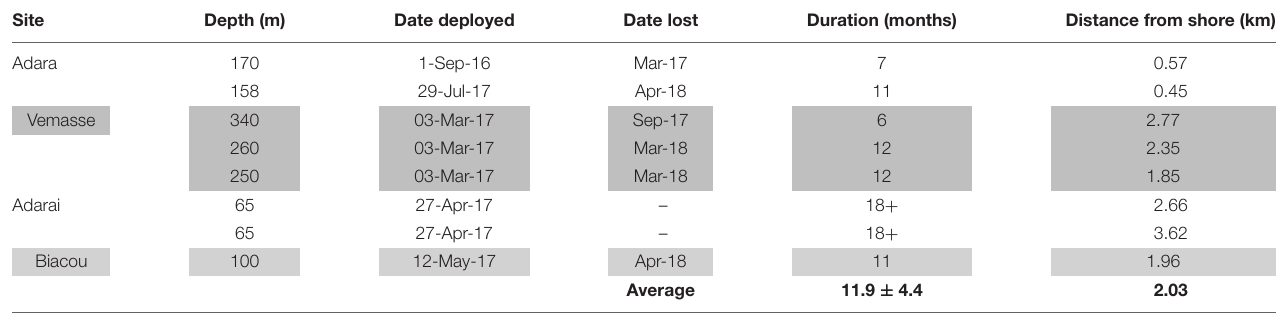
TABLE 1 | Deployment depth and longevity of artisanal nearshore fish aggregating devices at four community fishing sites in Timor-Leste. Site